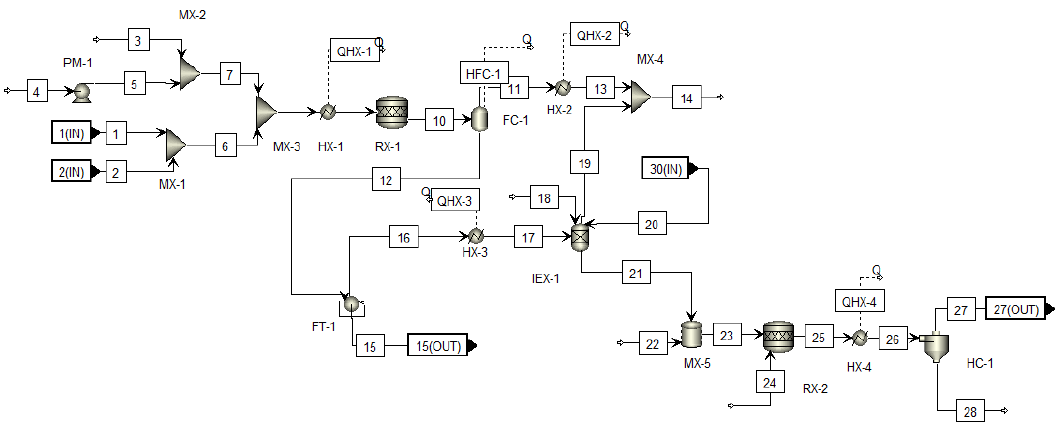
Figure 7. Pretreatment stage flowsheet in topology 2.